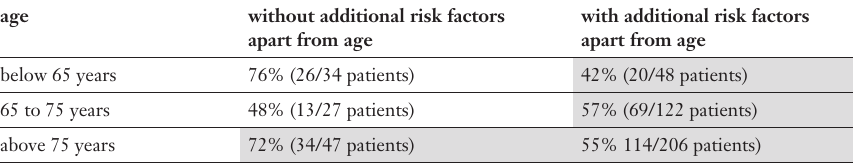
Estimated increased rate of stroke due to neglected antico- agulation in patients without contrain-